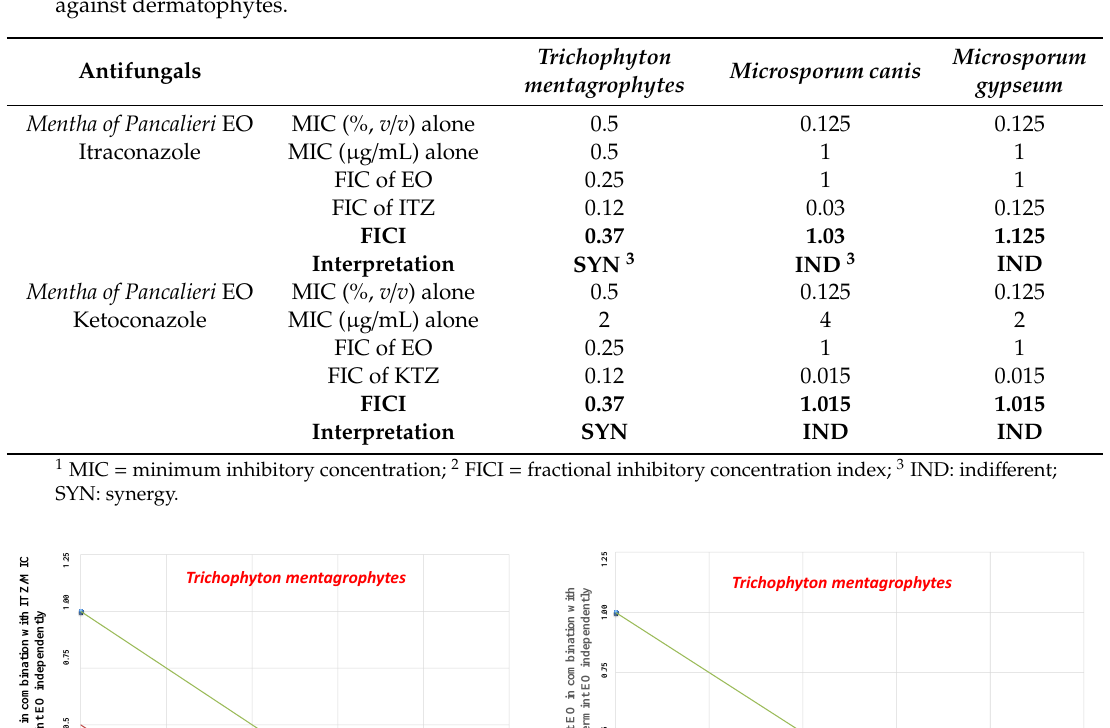
Table 6. MIC 1 and FICI 2 of the “Mentha of Pancalieri” EO plus itraconazole or ketoconazole against dermatophytes.